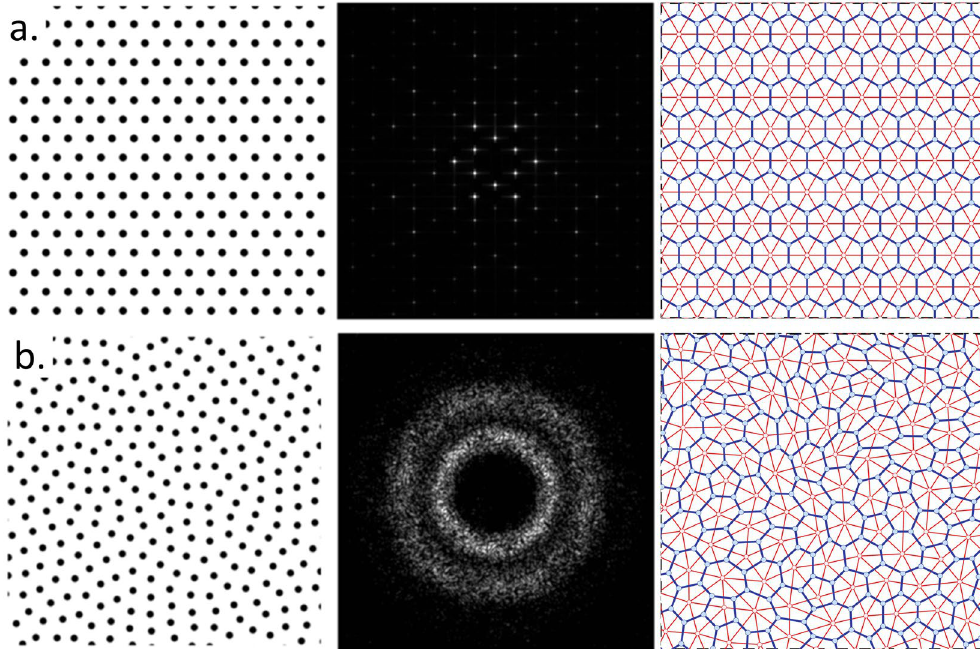
Figure 1. ( a ) Left to right: triangular lattice, its Fourier spectrum and the dual tessellation protocol which yields a honeycomb network. ( b ) Left to right: stealthy hyperuniform point pattern, its Fourier spectrum, and the dual tessellation protocol which transforms it in a trihedrally coordinated disordered